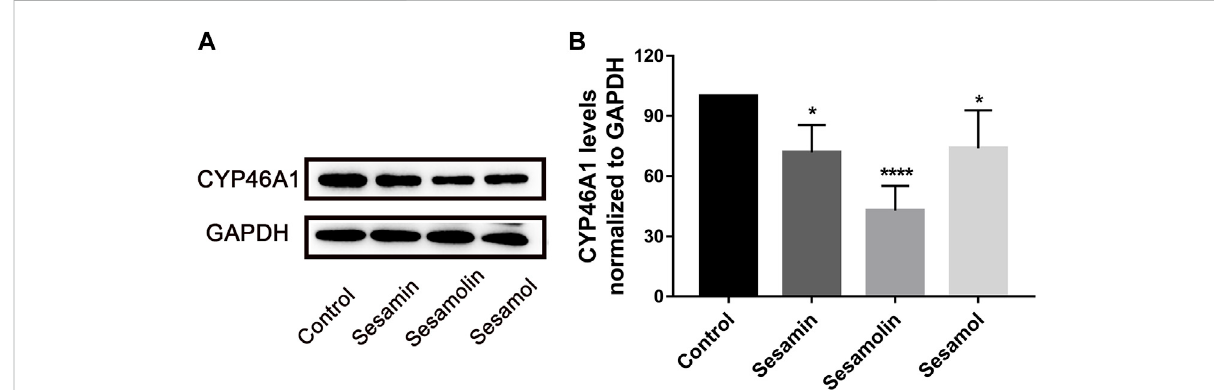
FIGURE 7 Effects of sesamin, sesamolin, and sesamol on protein expression of (A) and statistical analysis (B) of CYP46A1 in h-CYP46A1-Neuro-2a. Data were analyzed by one-way ANOVA and unpaired t-tests and are presented as mean ± SD from fi ve experiments carried out in duplicate. * p < 0.05, **** p < 0.0001 compared with control.